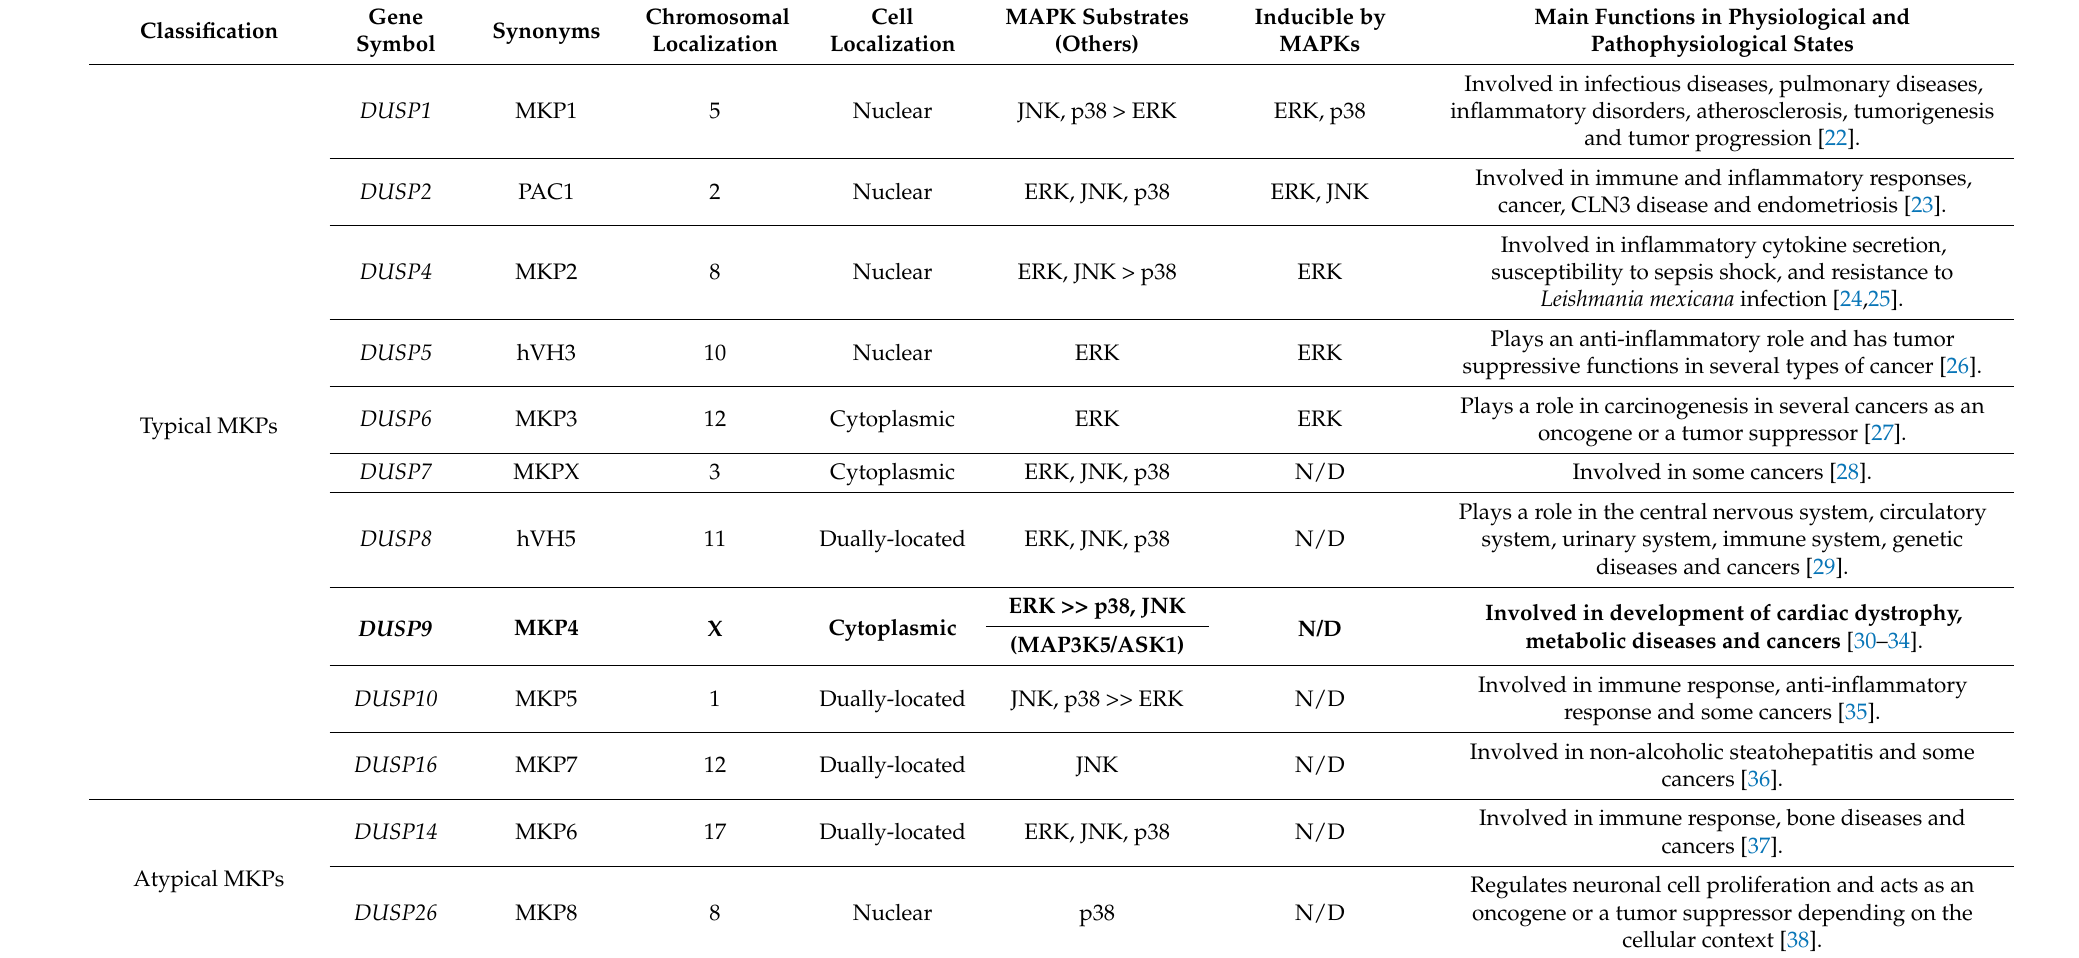
Table 1. General information and main functions of MAP kinase phosphatases